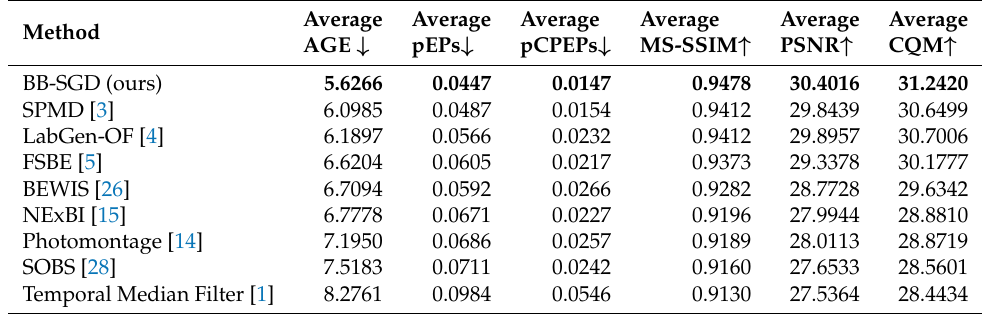
Table 1. Evaluation results per criteria on the SBMnet 2016 dataset. ↓ indicates lower score is better, ↑ indicates higher score is better. Source: SBMnet website http://pione.dinf.usherbrooke.ca/results/294/